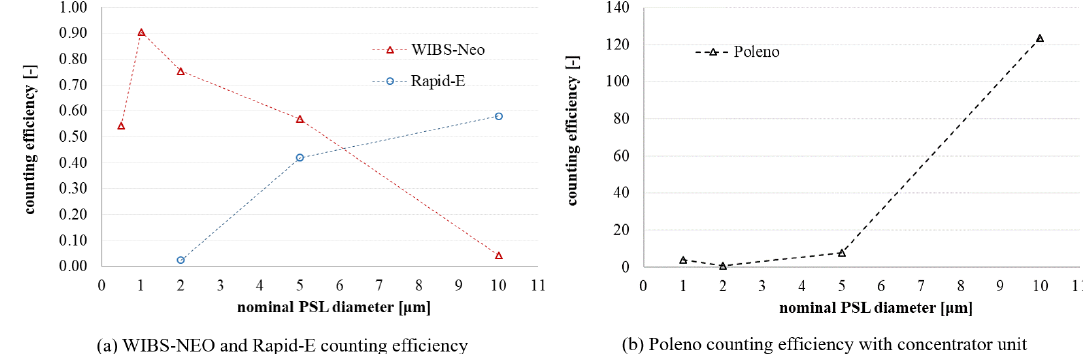
Figure 2. Counting efficiency for the three devices at different particle sizes. The value at 2µm diameter is the mean value of the three measurement sequences at 2.0, 2.07, and 2.1µm (i.e. red, plum purple, and blue, respectively).